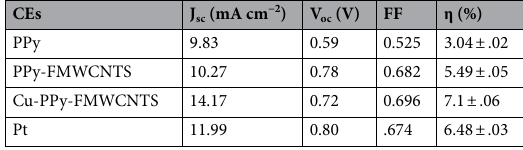
Table 3. Photovoltaic properties of DSSC with various nanocomposite